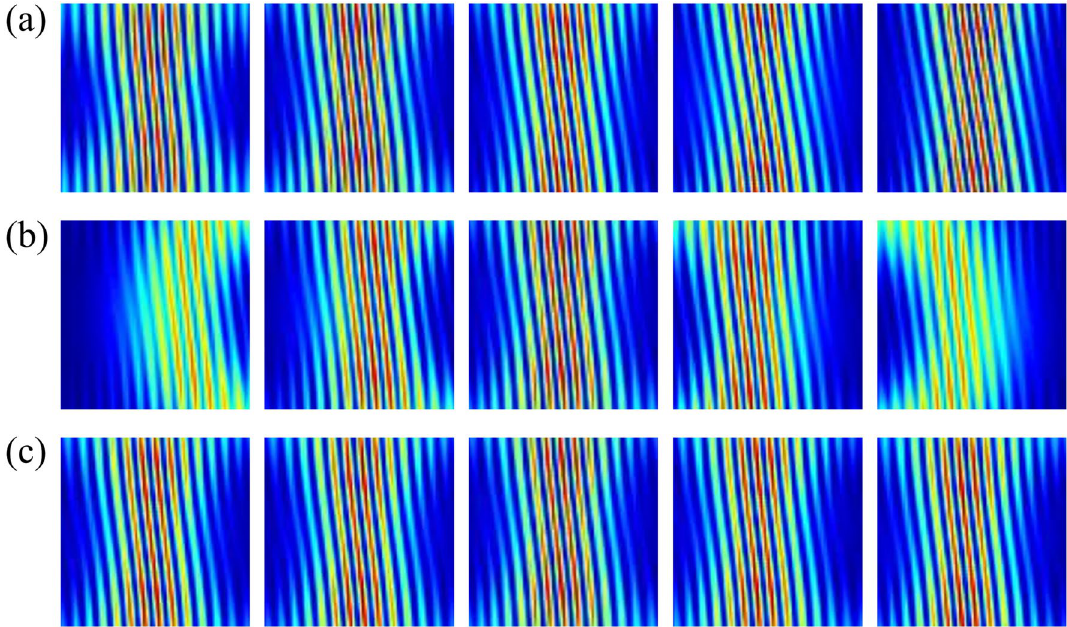
Figure 5. Experimentally detected holograms induced by geometric-phase-based shearing interferometry are presented. From left to right: ( a ) the OAM order increases from 2 to 6; ( b ) γ = − π/3, − π/6, 0, π/6 and π/3 with